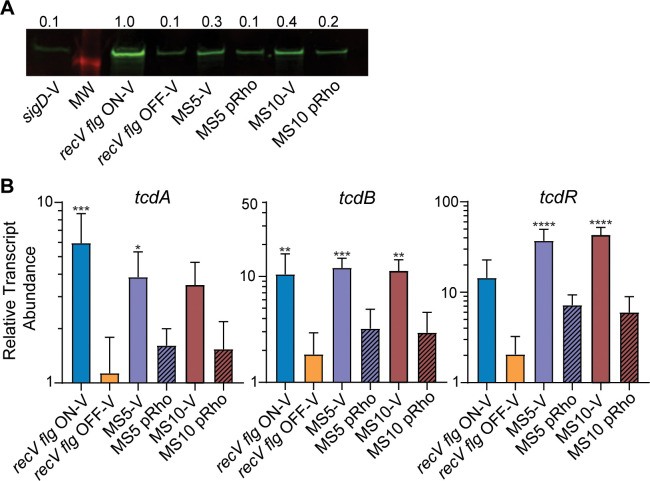
Mutations in rho impact toxin production.(A) Immunoblot detection of TcdA by MS5 and MS10 bearing pRho for expression of wild-type rho or bearing vector. Controls included recV flg ON, recV flg OFF and sigD mutant carrying vector. Shown is a representative image for three independent experiments. Numbers represent quantification of band intensity expressed as the fold change compared to recV flg ON for the image shown. (B) Relative transcript abundance of tcdA, tcdB, and tcdR measured by qRT-PCR. The means and standard deviation from 3 to 5 biological replicates per strain are shown. ****p<0.0001, ***p<0.001, **p<0.01, *p<0.05 by one-way ANOVA and Dunnett’s post-test compared to recV flg OFF.